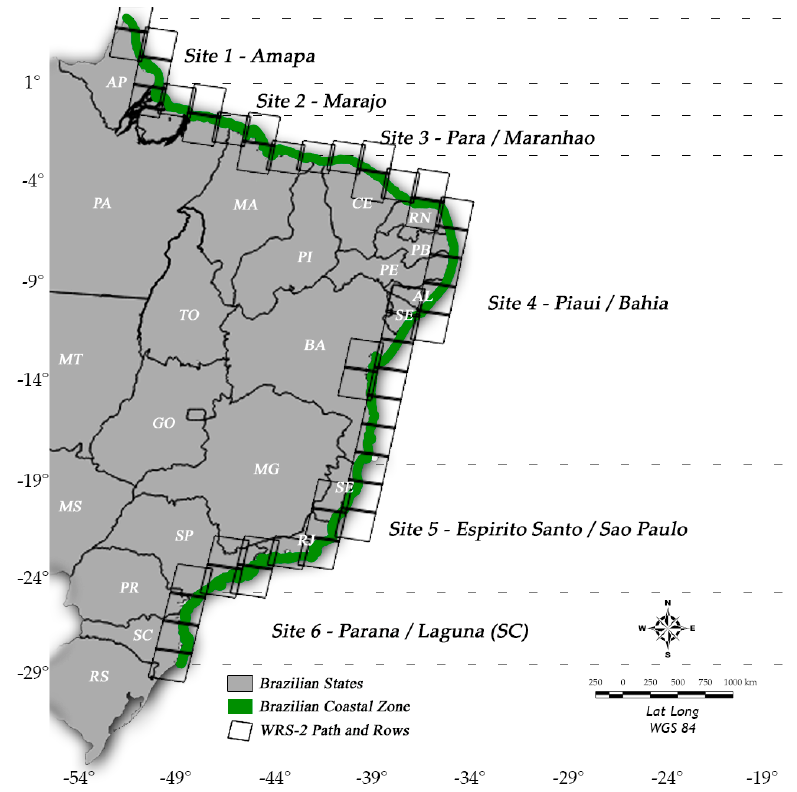
Figure 2. The Brazilian coastal region was split into six (6) distinct sectors. Site 1—Amapá; Site 2— Marajó Island; Site 3—Pará/Maranhão; Site 4—Piauí/Bahia; Site 5—Espírito Santo/São Paulo; and Site 6—Paraná/Laguna (SC). The north and south boundaries of the Brazilian mangroves are in green. The Brazilian coastal states: AL (Alagoas), AP (Amapá), BA (Bahia), CE (Ceará), ES (Espírito Santo), MA (Maranhão), PA (Pará), PB (Paraíba), PE (Pernambuco), PI (Piauí), PR (Paraná), RJ (Rio de Janeiro),